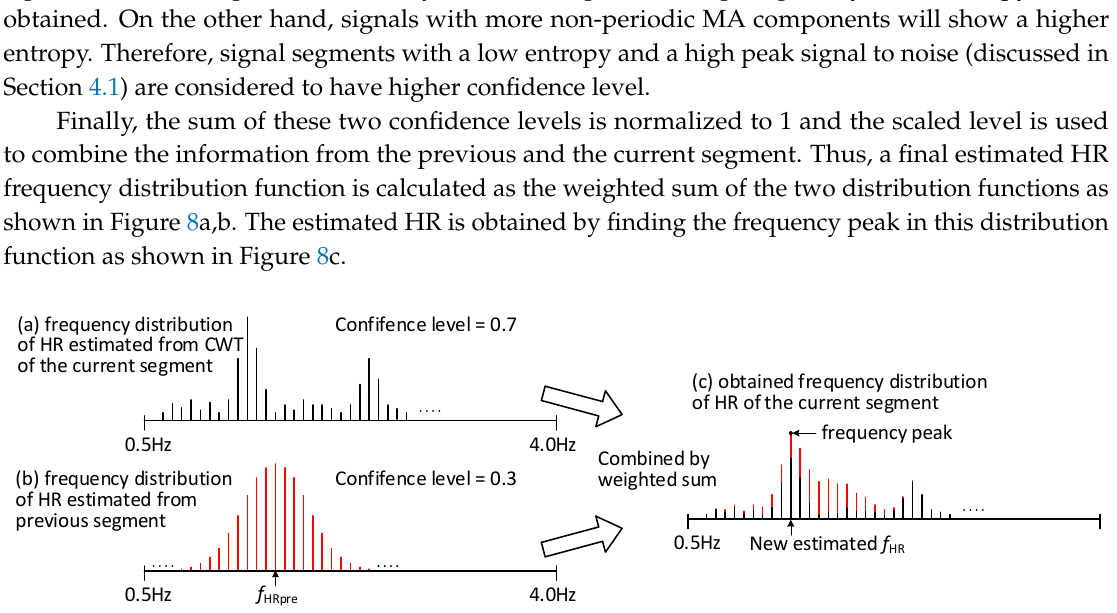
Figure 8. Approximate HR estimation based on weighted sum: ( a ) the frequency distribution estimated from CWT of the current segment, ( b ) the frequency distribution estimated from previous segment ( c ) the obtained frequency distribution of the current segment